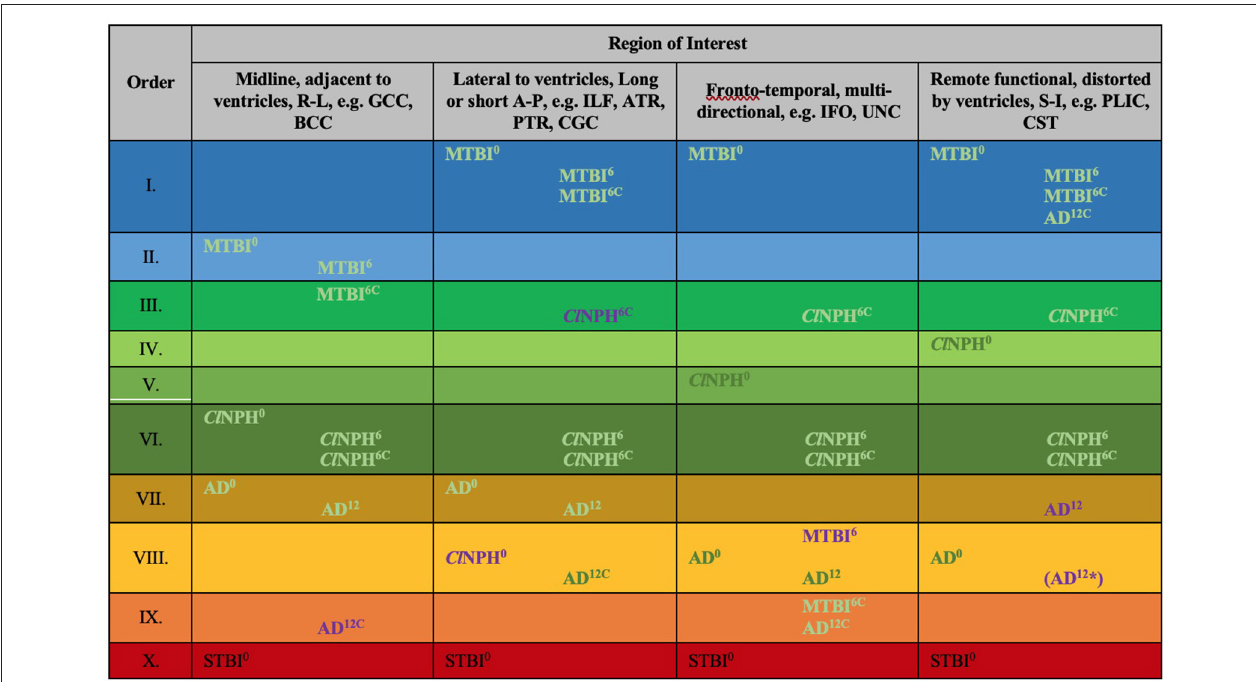
FIGURE 8 | Periodic table of DTI elements. Recurring common properties of DTI profiles arranged vertically by predicted reversibility of white matter injury (see Table 4 and Discussion). ROIs grouped in columns of ‘white matter families’ according to distortion potential from ventriculomegaly. Differences at baseline for clinical cohorts at 0 months vs. healthy controls at 0 months mapped onto the periodic table. In addition to baseline DTI profiles, cohorts mapped across timepoints; MTBI 6 , Cl NPH 6 and AD 12 cohorts are mapped at 6 and 12 months respectively against healthy controls at 0 months; Cl NPH 6C and MTBI 6C are mapped at 6 month follow-up against the respective clinical cohorts at 0 months. Order X has been derived from STBI data in a published cohort by Veenith et al. ( 77); coincidentally, this unrelated study was performed on the same scanner as the Cl NPH cohort being described in this work. 0 / 6 / 12 , DTI profiles at 0 month baseline, 6/12 month follow-up, C , denotes cohorts vs. themselves across timepoints, A-P, anterior-posterior; AD, Alzheimer’s Disease; BCC, body of the corpus callosum; Cl NPH, Classic NPH; DTI, diffusion tensor imaging; FA, fractional anisotropy; IFO, inferior fronto-occipital fasciculus; ILF, inferior longitudinal fasciculus; L1, axial diffusivity, L2 and 3,